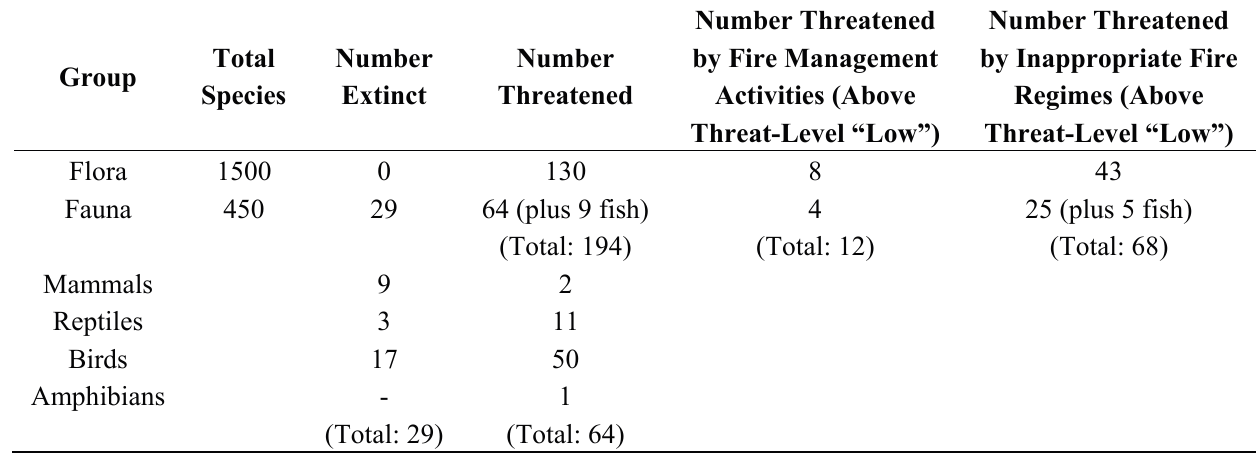
Table 1. A snapshot of the conservation status of species in the Adelaide-Mt Lofty Region [25].